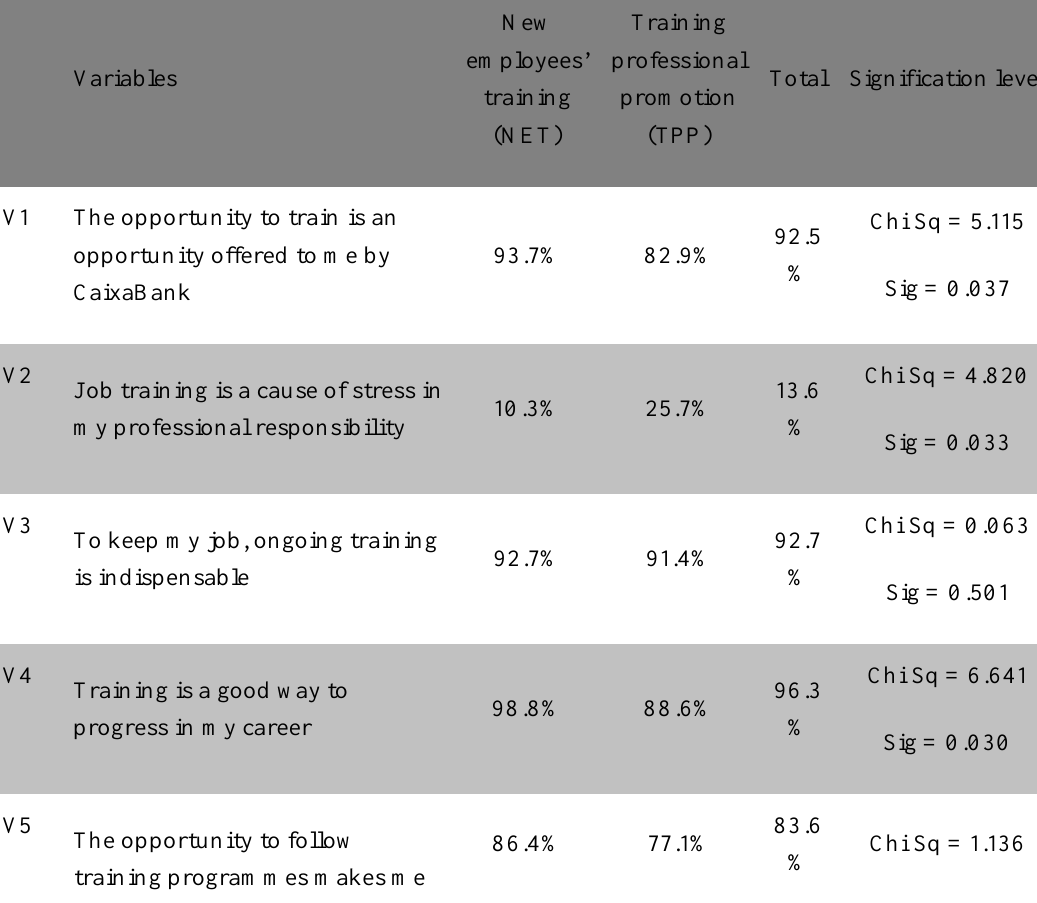
New employees’ training